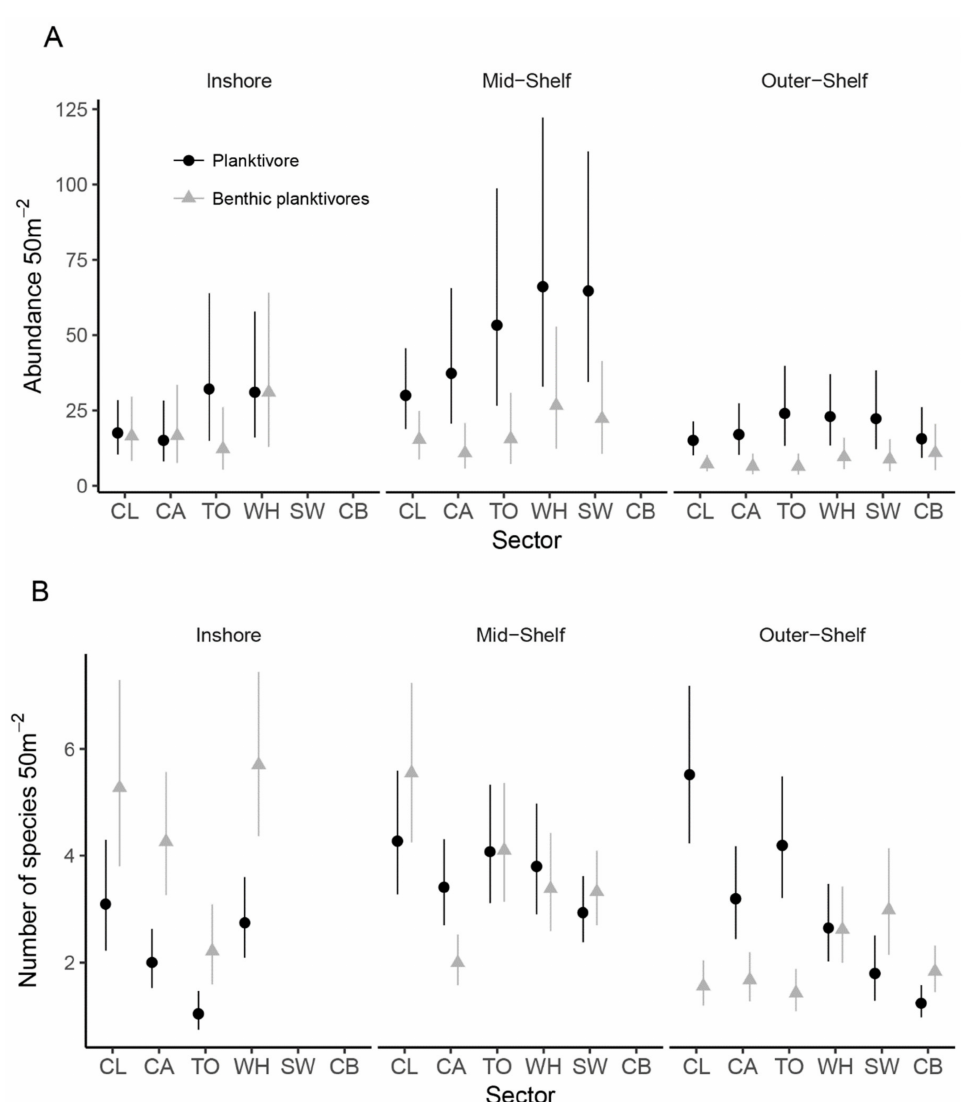
Figure 3. Time averaged spatial patterns in the ( A ) density and ( B ) species richness of planktivorous damselfishes on the Great Barrier Reef. Data are modelled higher posterior distribution means and associated 95% uncertainty intervals (UIs) from Bayesian hierarchical linear mixed